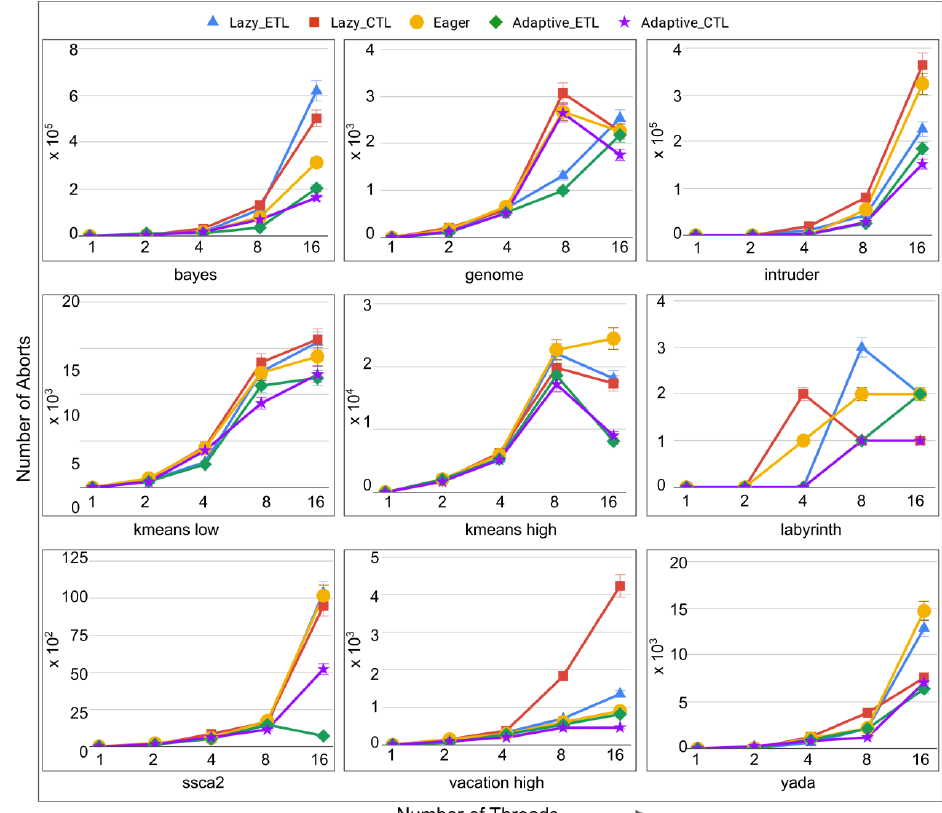
Figure 15. Total number of aborts in STAMPEDE benchmarks in persistent